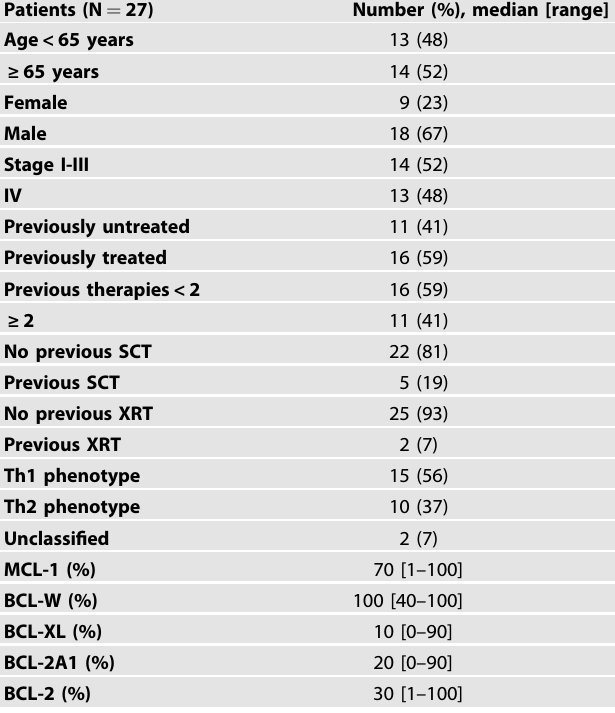
Table 1. Baseline characteristics of the patients with PTCL-NOS.